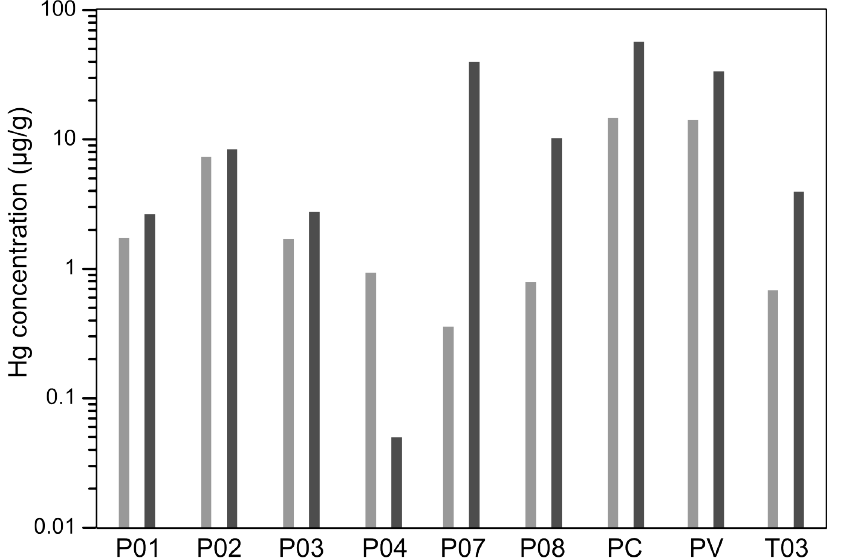
Figure 5. Semi-logarithmic plot showing the comparison between total Hg concentrations before and after the November 2012, flood event. Light grey columns represent the concentration before the flood (from the 2010 and 2012 campaigns), while the dark grey ones indicate the post flood data (2013). 2010 data are available in the literature [16] and refer to P07, P08, PC and PV sampling